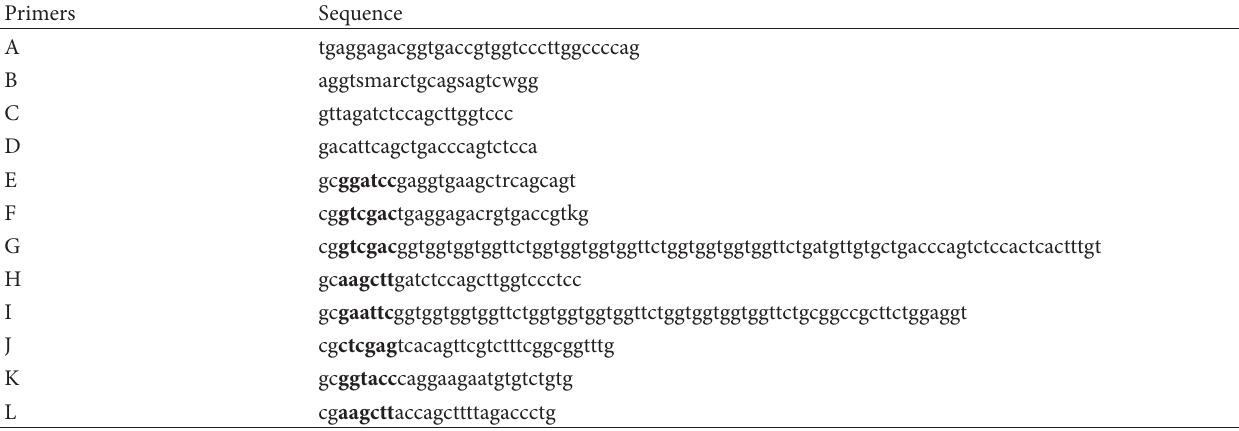
Table 1: Sequences of the primers used in this study are listed as A to